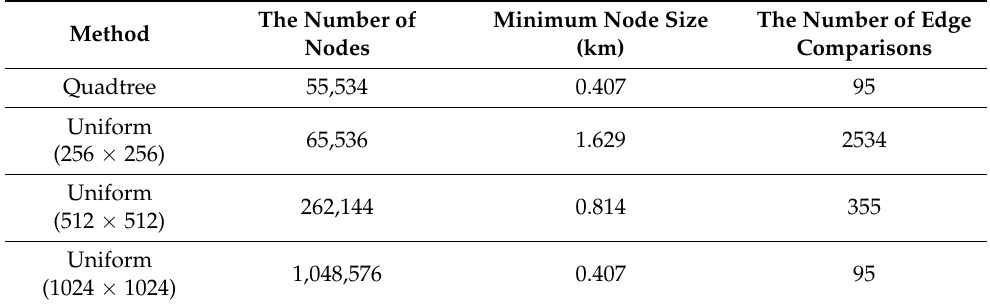
Table 1. Comparison of the results obtained using the quadtree and uniform methods (Trajectory 1).